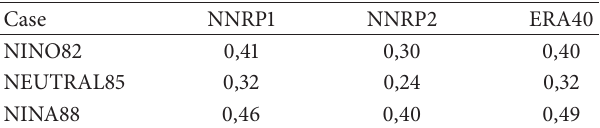
Table 1: Summary statistics to three simulations and REAL data for annual values.